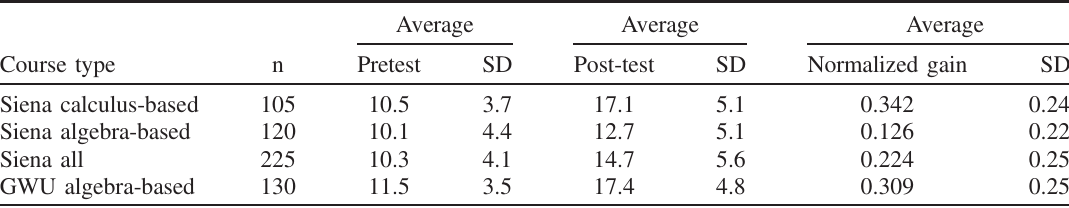
TABLE III. Average scores and standard deviation for pretest, post-test, and normalized gain.